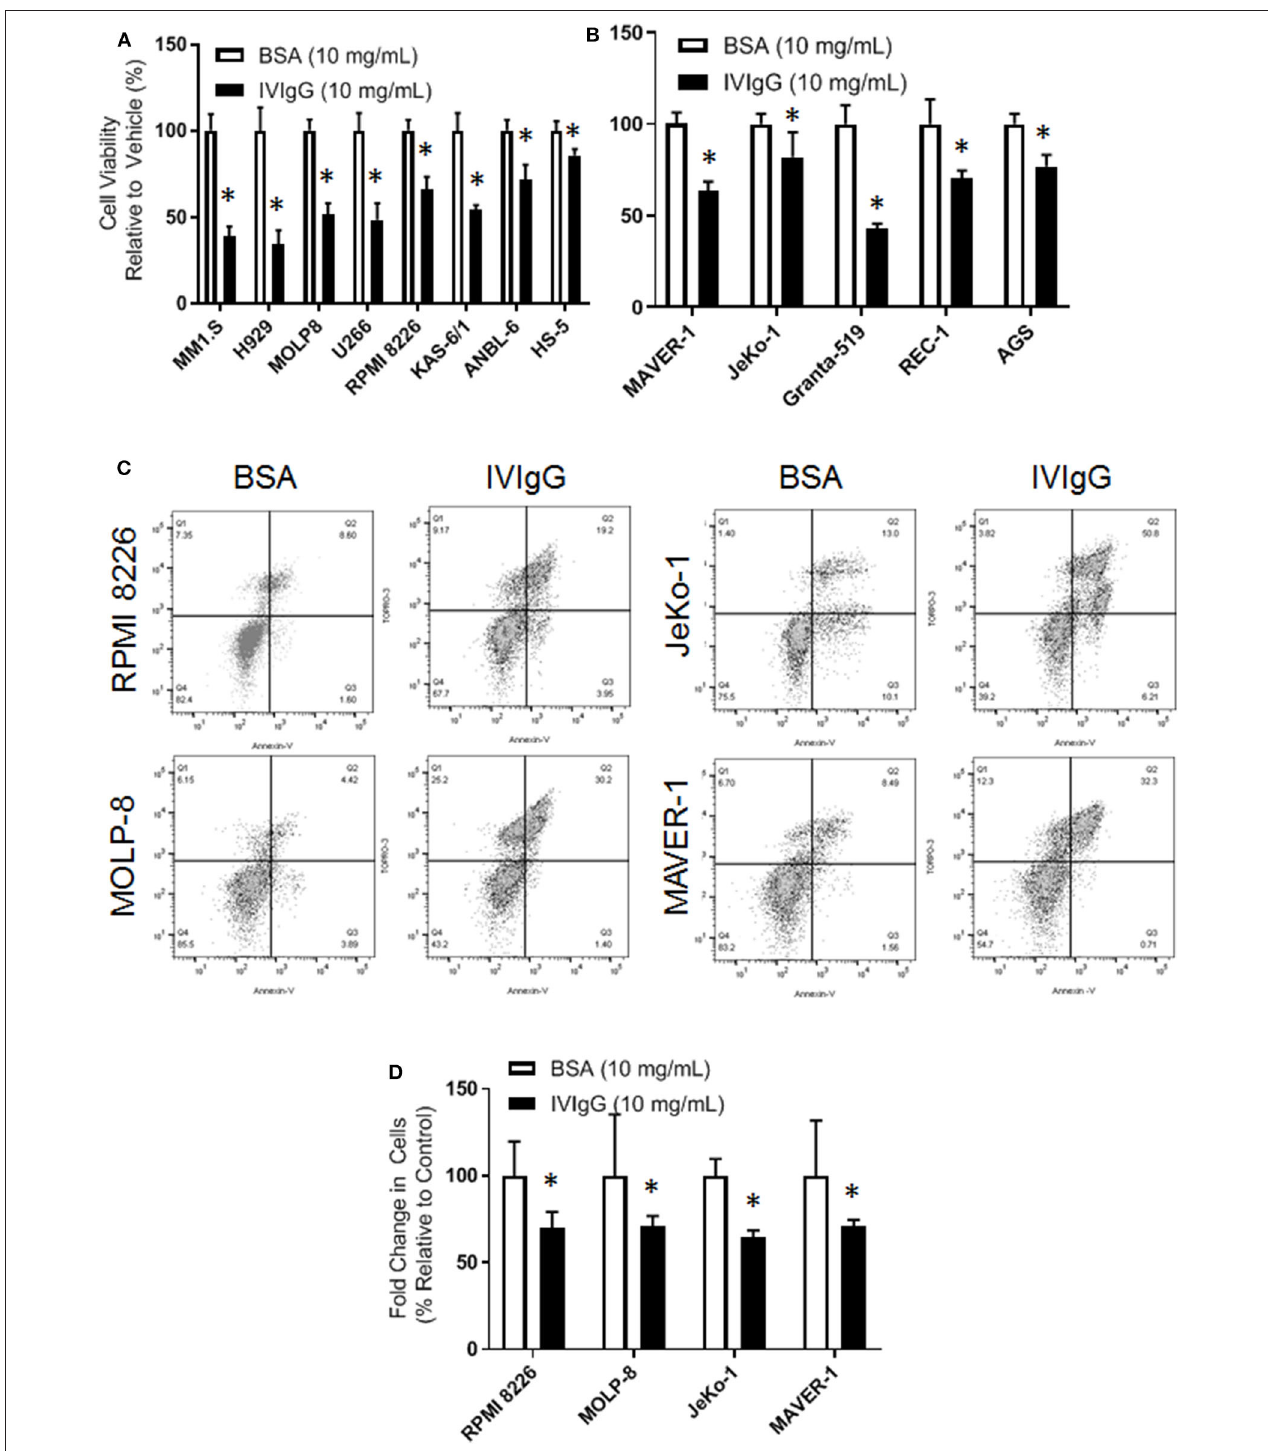
FIGURE 1 | IVIgG inhibits growth of multiple myeloma and lymphoma cell lines. (A) Myeloma cell lines and the stromal cell line HS-5 were exposed for 72h to IVIgG or bovine serum albumin (BSA), and cell viability was determined using the WST-1 assay. Results are expressed as the percentage viability relative to the vehicle control, which was arbitrarily set as 100%. (B) Cell viability of MCL cell lines and the Fc-gamma receptor-negative gastric cell line AGS after exposure to BSA vs. IVIgG was determined as above. (C) Flow cytometric analysis of RPMI 8226 and MOLP-8 cells, as well as of JeKo-1 and MAVER-1 cells exposed to BSA or IVIgG (10 mg/mL) for 72h was performed after staining with Annexin V/TO-PRO-3. (D) Annexin V/TO-PRO-3 and Count Bright Bead flow was used to determine the change in viable cell number in response to BSA versus IVIgG. The values shown represent the mean ± standard error of the mean from three independent experiments, and an unpaired t -test was used to evaluate significance, where “*” denotes p < 0.05.